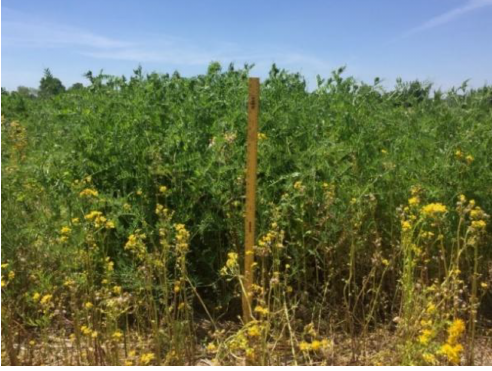
Figure 3. Hairy vetch height at the time of termination on 12 May 2017.